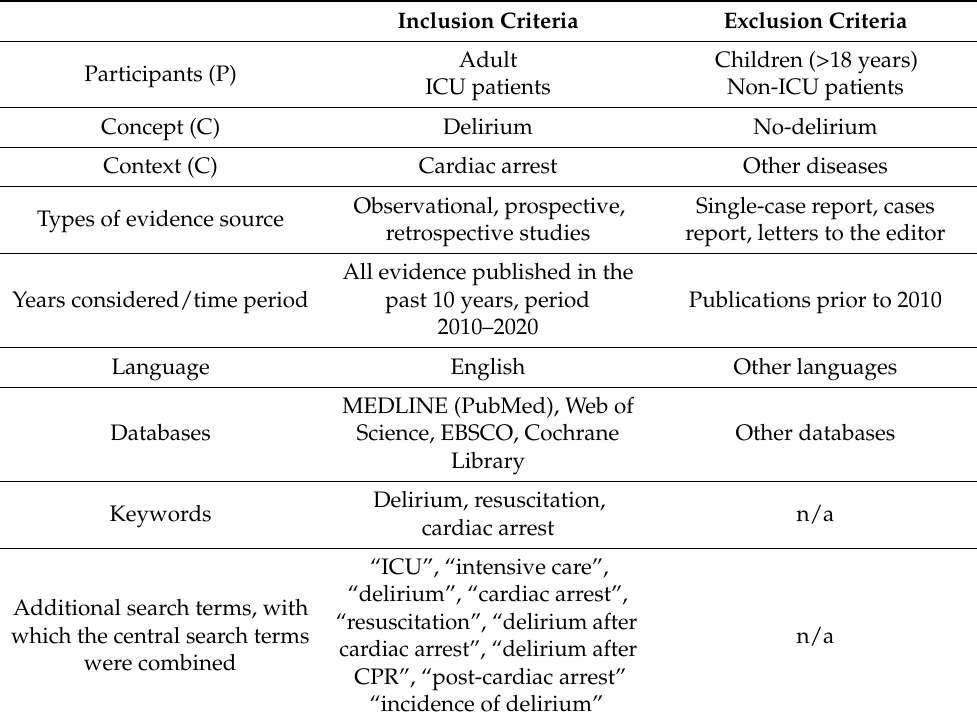
Table 1. PCC framework, inclusion and exclusion criteria, search strategies. Inclusion